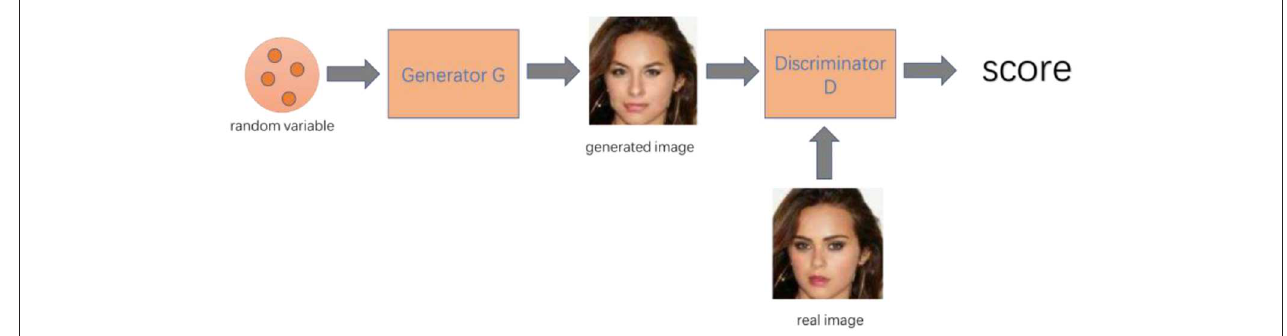
FIGURE 1 | Digital image diagram of